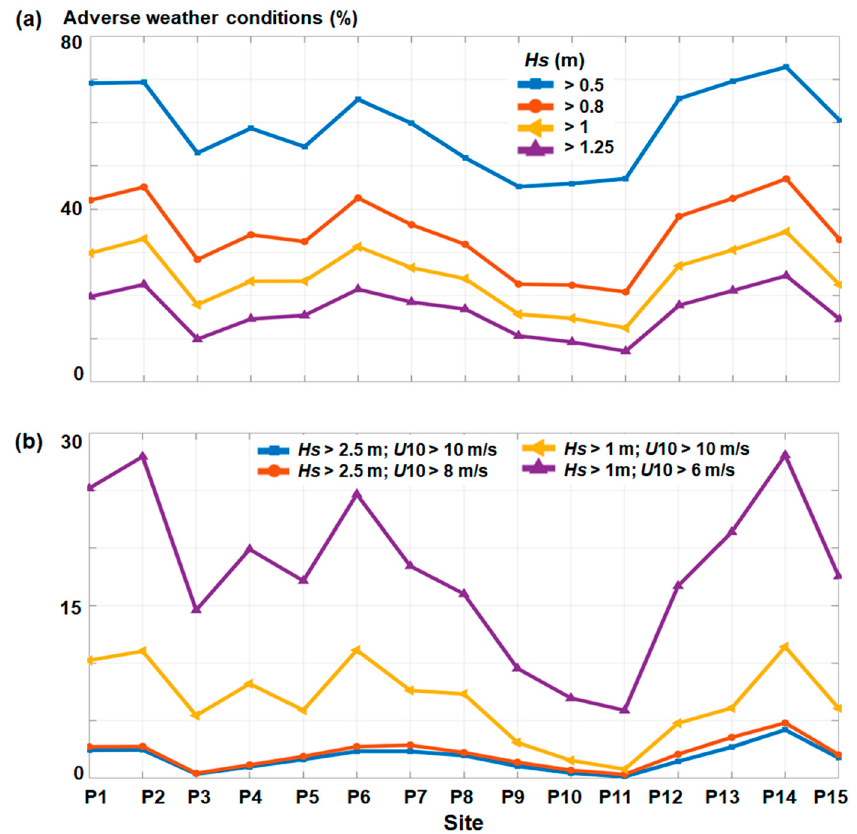
Figure 8. Adverse weather conditions (in %) reported by the reference sites, considering the time interval from 1987 to 2016, where: ( a ) wave conditions; ( b ) joint distribution of the wind and wave conditions.